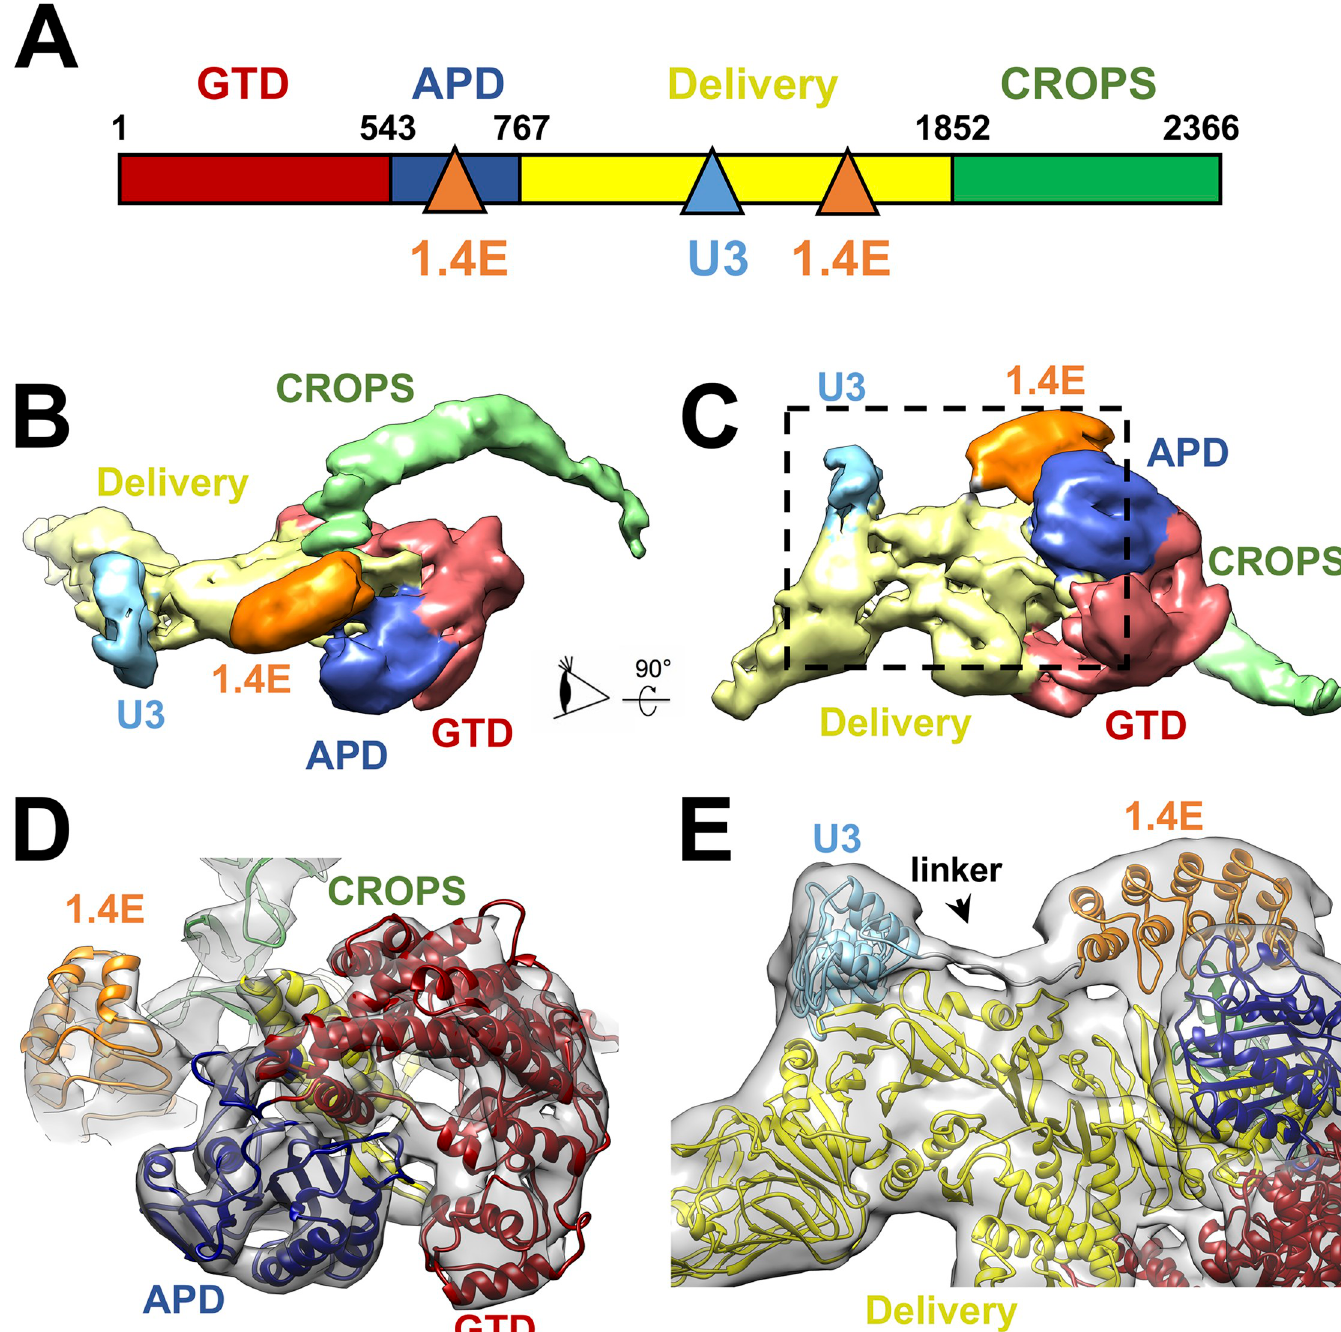
Fig 7. Cryo-EM structure of the TcdB–DLD-4 complex. (A) Domain organization of TcdB and its interaction with the 2 modules of the DLD-4 DARPin. The binding sites on TcdB for DLD-4 are indicated by the blue and orange triangles for the U3 and 1.4E modules, respectively. (B) Density map of the TcdB–DLD-4 complex with the functional domains and DARPin modules in different colors. (C) The same map but rotated 90˚ as indicated by the arrow. (D) The model fitted into the map as viewed from the eye cartoon labeled in Panel B. The density map is iso-surfaced at a threshold of 9 σ . (E) Zoom-in of the region labeled within the dashed black box in Panel C to show the linker between DARPins U3 and 1.4E. The density map is iso-surfaced at a threshold of 3.8 σ . APD, autoprocessing domain; CROPS, combined repetitive oligopeptides; cryo-EM, cryo-electron microscopy; DARPin, designed ankyrin repeat protein; GTD, glucosyltransferase domain; TcdB, C . difficile toxin B.